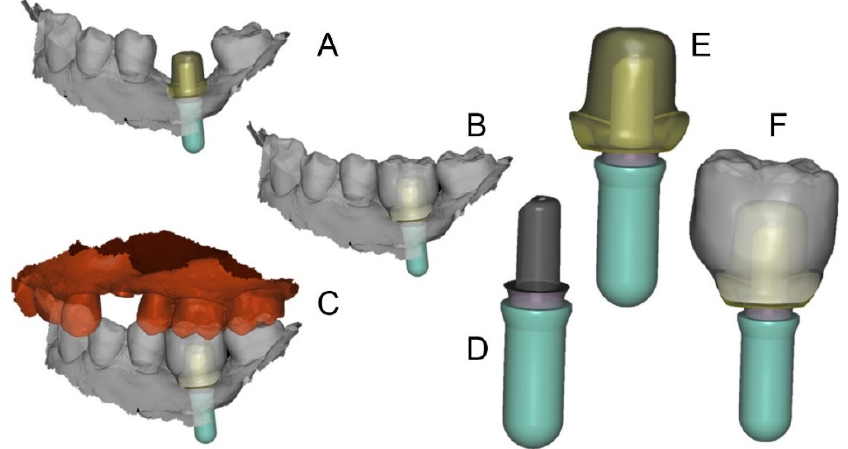
Figure 3. First CAD scene (PLAN1) with Exocad DentalCAD ® (Darmstadt, Germany). ( A ) the individual hybrid abutment in position; ( B ) the individual hybrid abutment and the provisional crown in position; ( C ) bite registration; ( D ) in this case, the selected titanium base was a Multitech ® straight (Leone implants, Florence, Italy); ( E ) the individual abutment has been modeled; ( F ) details of the assembly.